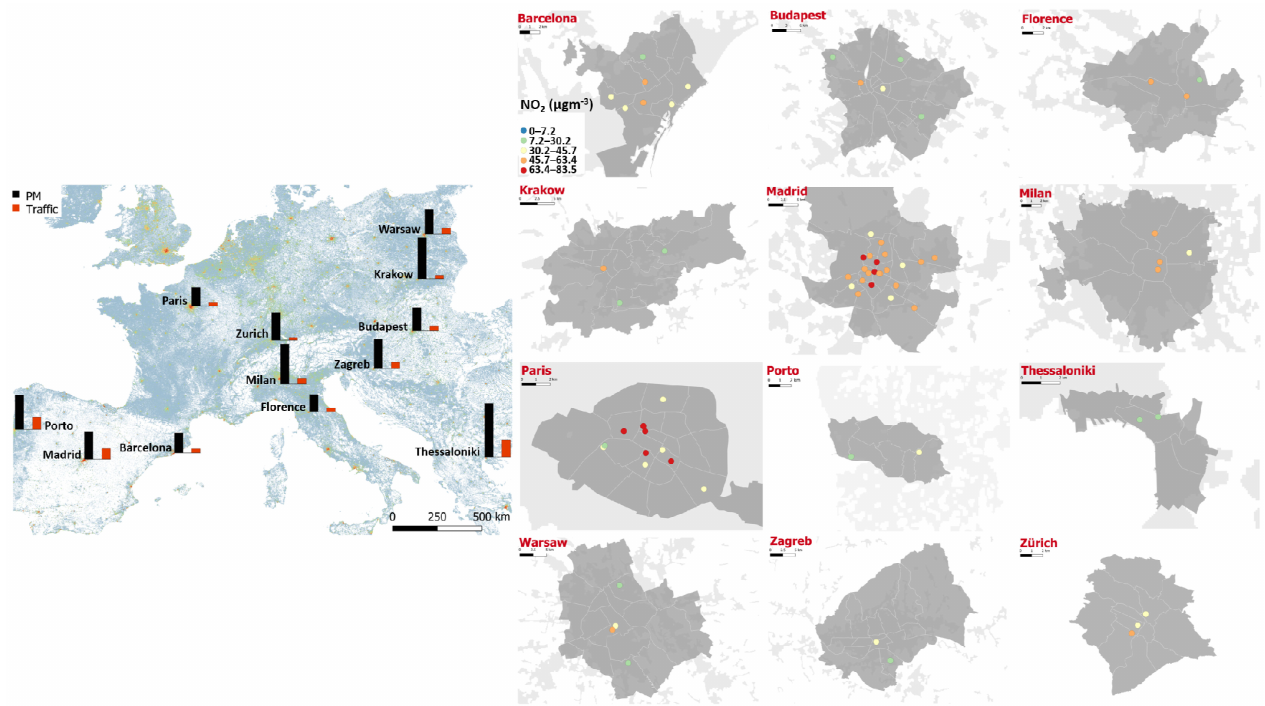
Figure 1. Location of the selected cities, with a visual comparison of PM 2.5 and PM 2.5 traffic contribu- tion ( left ), and location of NO 2 monitoring stations, indicating concentration ranges ( right